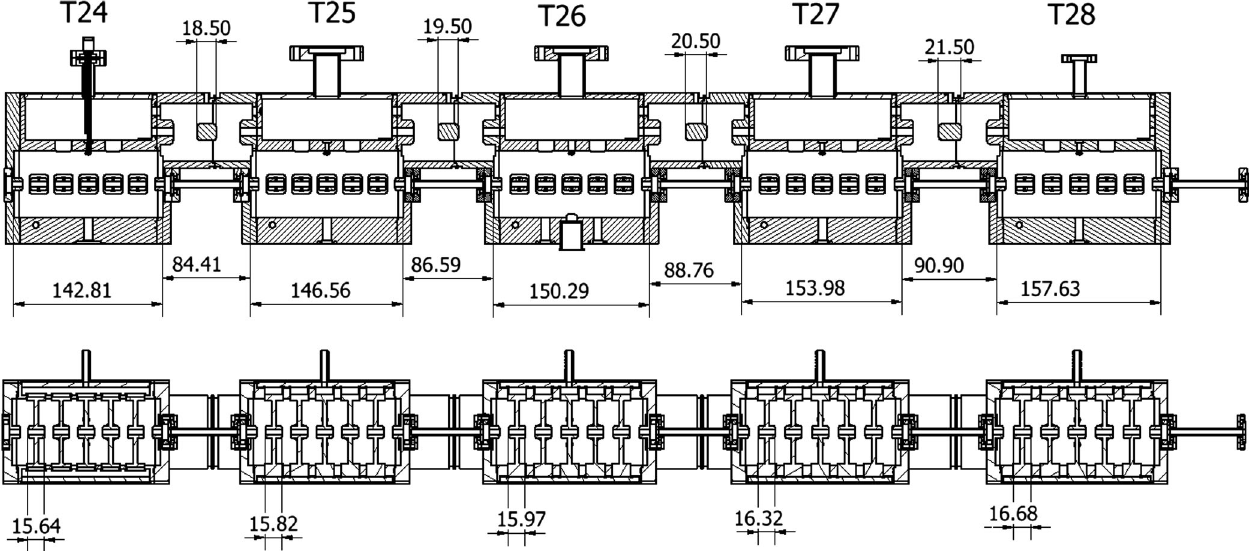
FIG. 2. Two longitudinal sections (top and lateral view) of module 4 with the main dimensions (in millimeters). PMQs are mounted between two neighboring tanks (not shown).